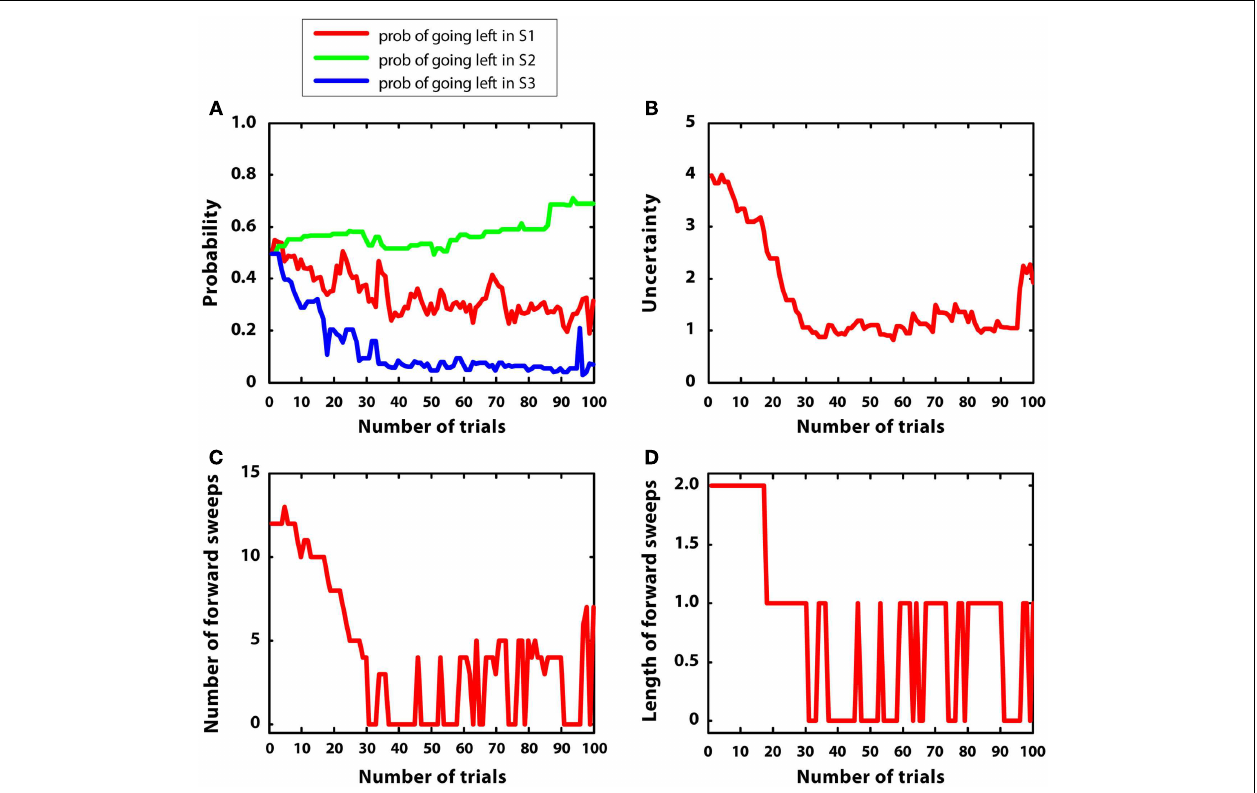
FIGURE 9 | Results of simulation 5, complex environment with high variance. (A–D) : see Figure 5 .